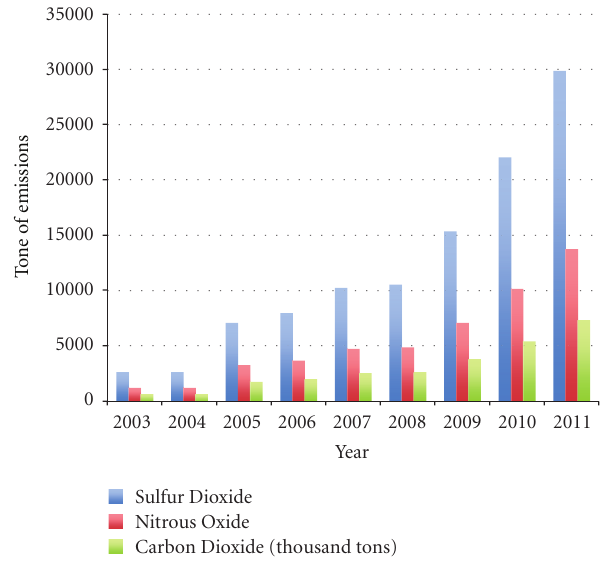
F 4: Estimated emissions